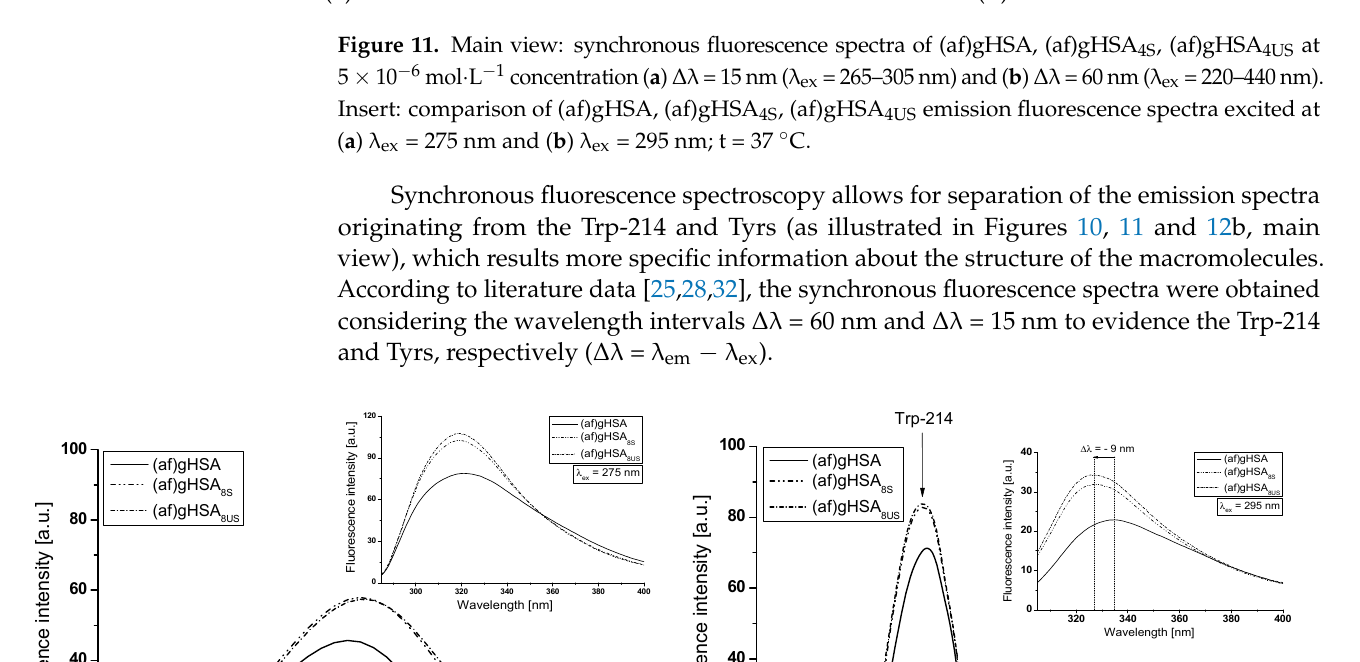
Figure 11. Main view: synchronous fluorescence spectra of (af)gHSA, (af)gHSA 4S , (af)gHSA 4US at 5 × 10 − 6 mol · L − 1 concentration ( a ) ∆ λ = 15 nm ( λ ex = 265–305 nm) and ( b ) ∆ λ = 60 nm ( λ ex = 220–440 nm). Insert: comparison of (af)gHSA, (af)gHSA 4S , (af)gHSA 4US emission fluorescence spectra excited at ( a ) λ ex = 275 nm and ( b ) λ ex = 295 nm; t = 37 ◦ C.